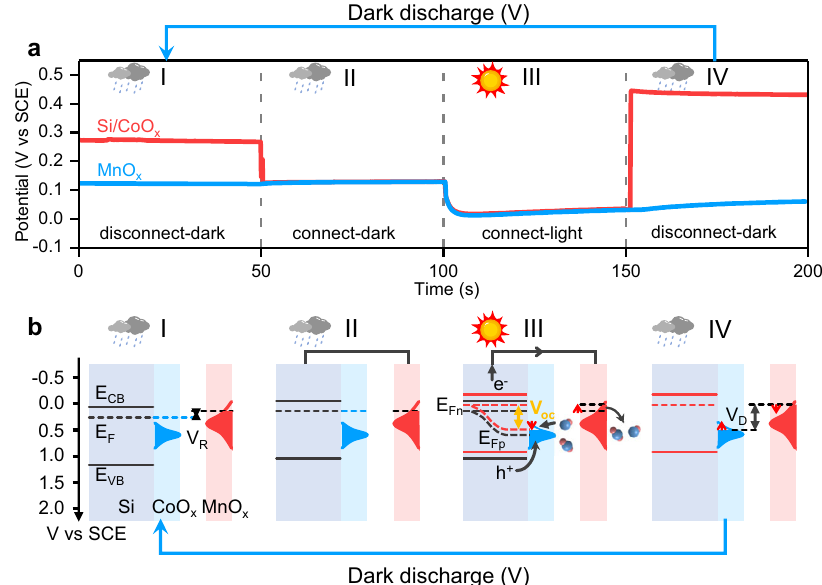
Fig. 3 A mechanism of the photovoltage memory effect in a Si/CoO x /KBi (aq) /MnO x Faradaic junction device. a OCPs of a Si/CoO x photoelectrode and a MnO x counter electrode under illumination and in the dark. The OCPs were measured under disconnected and connected modes. Light source: 1 Sun of simulated solar illumination by a Xe lamp with AM 1.5 G fi lter (100 mW cm − 2 ), electrolyte: KBi aqueous solution (0.2 M KOH and 0.4 M H 3 BO 3 ) with pH = 9. b Energy band diagrams of Si/CoO x /KBi (aq) /MnO x at different working stages. E VB and E CB are the valence band and conduction band of a semiconductor, respectively; E Fn and E Fp represent the quasi-Fermi levels of electrons and holes, respectively; V R is a residue voltage between a photoelectrode and a counter electrode; V oc represents a photovoltage and V D represents a dark output